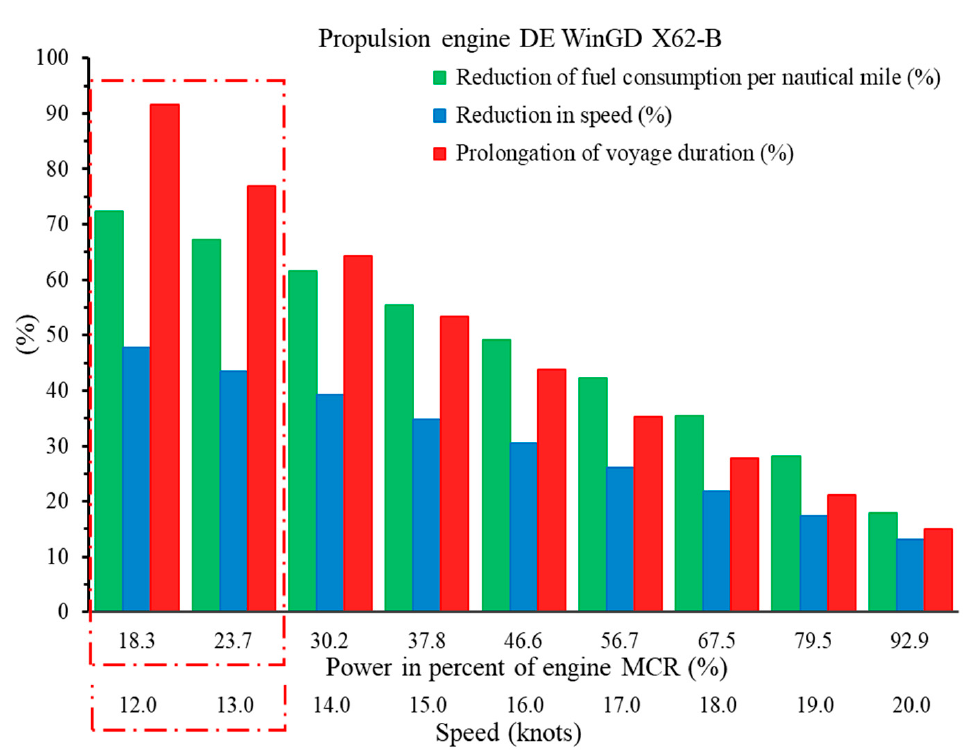
Figure 12. Propulsion with one low-speed diesel engine-configuration 1.